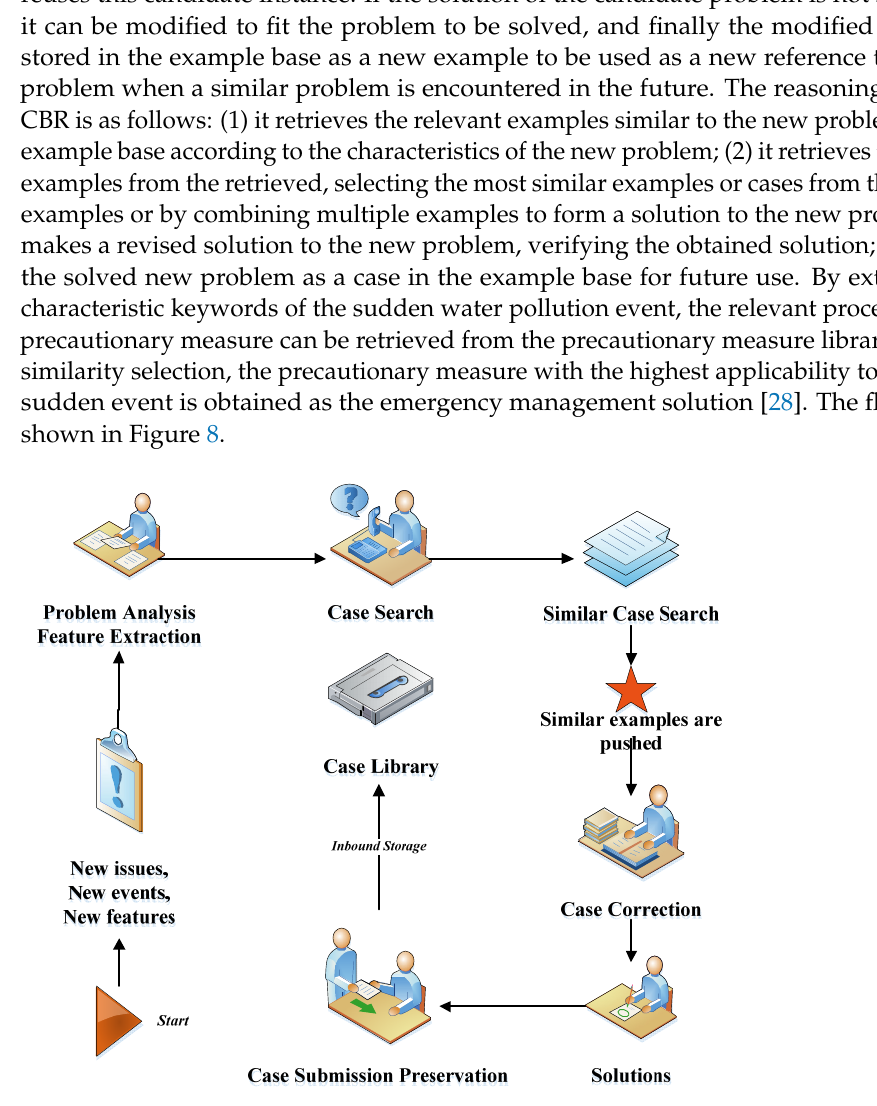
Figure 8. CBR Figure 8. CBR workflow.